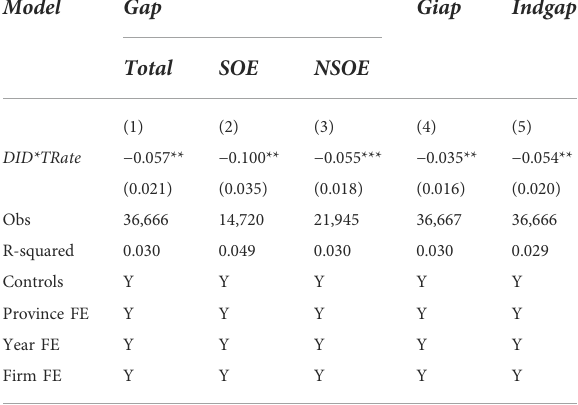
TABLE 6 Tax reduction mechanism estimation results. Model